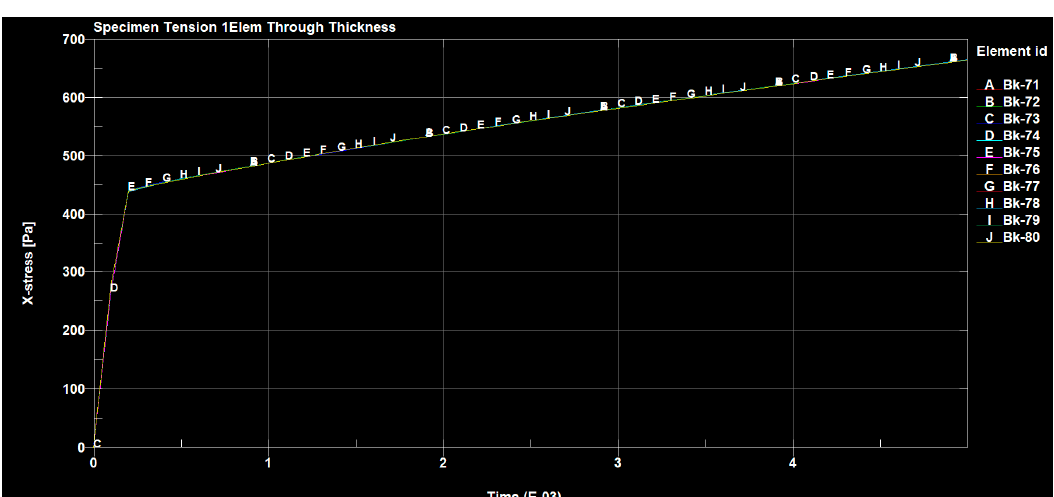
Figure 27. Sample deformation in the 𝑥 direction.